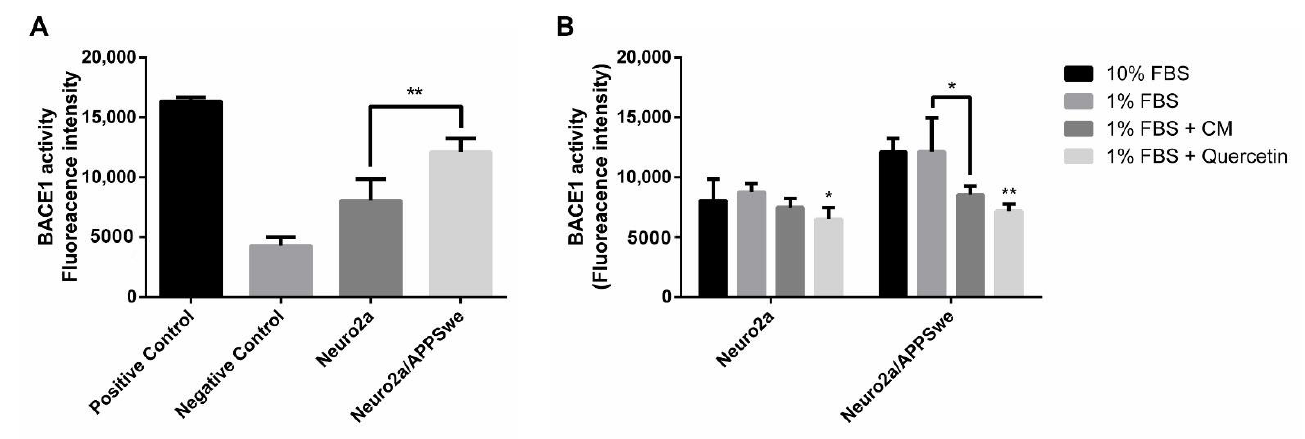
Figure 10. BACE1 activity expressed as fluorescence intensity unit per 30 µg of protein sample. ( A ) Neuro2a/APPSwe cells showed significantly higher level of BACE1 activity than Neuro2a cells after 48 h of treatment in 1% FBS medium. The enzyme activity correlated with the enzyme concentration. ( B ) Quercetin (1 µM), a well-known BACE1 inhibitor, significantly decreased the enzyme activity in both cells. BACE1 activity in Neuro2a/APPSwe cells significantly decreased upon treatment with 10 µg/mL of CM extract for 48 h compared to 1% FBS treatment, and it slightly decreased in Neuro2a cells. Values are mean ± SD of at least three independent experiments. * p- value < 0.05, ** p- value < 0.01.